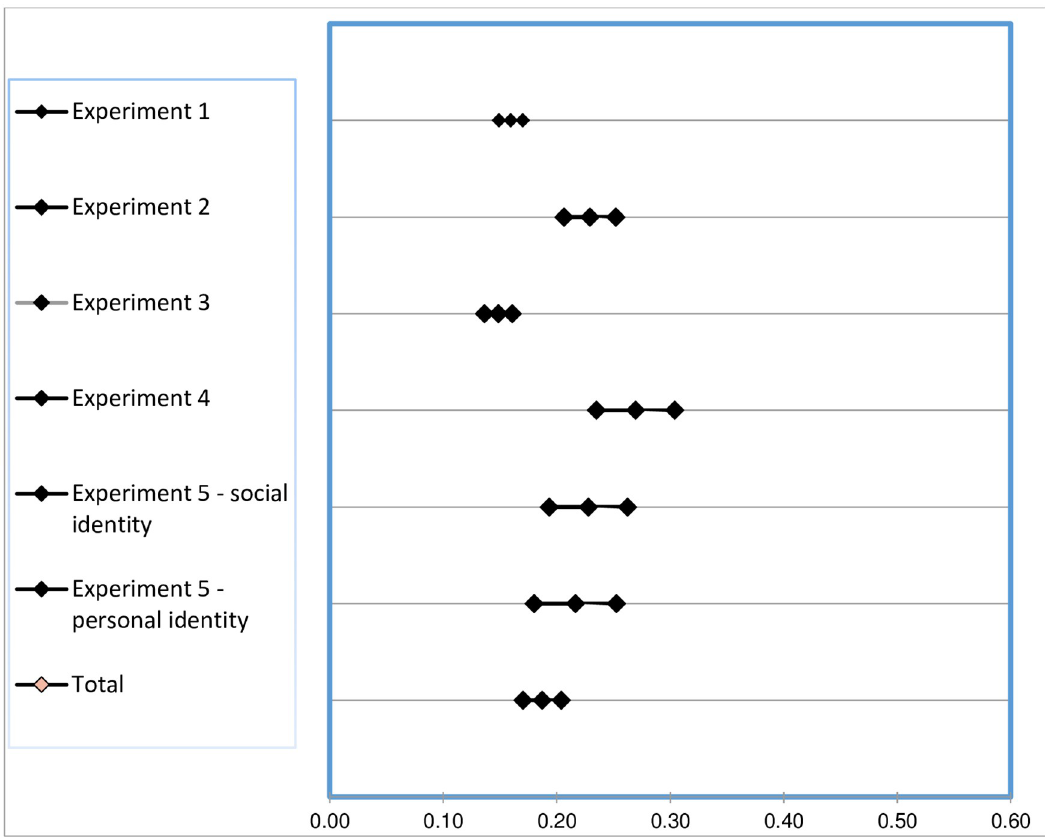
Fig 3. Effect sizes of the internal